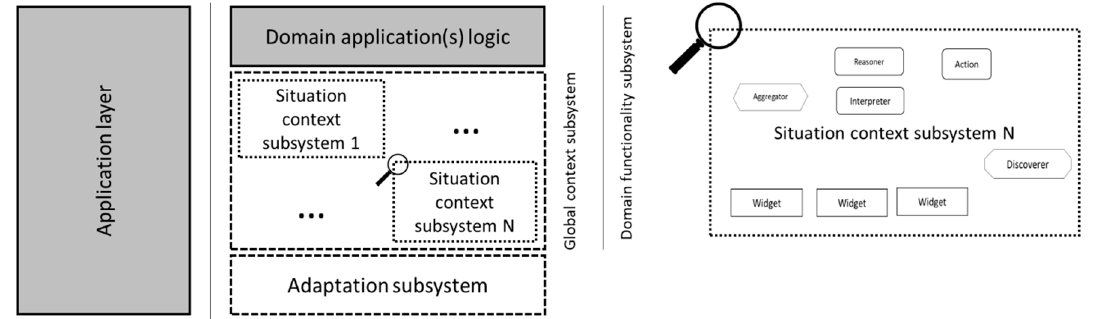
Figure 1. The proposed framework for developing Internet of Things (IoT) applications is made up of the adaptation subsystem and the global context subsystem. The latter is made up of different situation context subsystems, which are specified using the abstractions defined in [18]